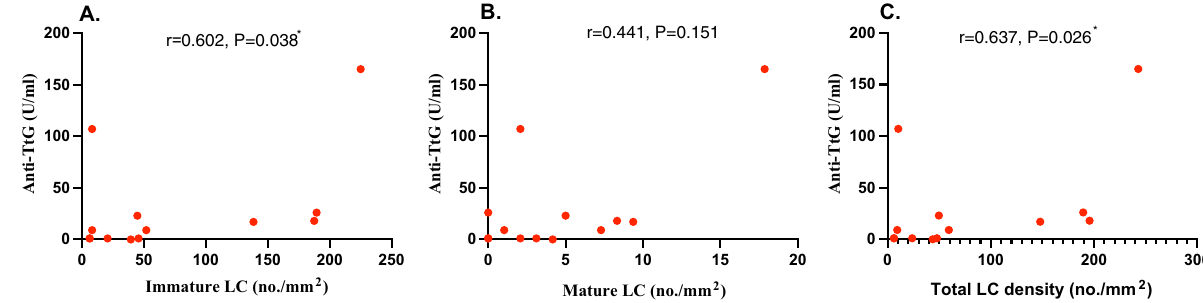
Figure 2. Correlation between Anti-TtG levels and immature ( a ), mature ( b ) and ( c ) total LC density in children with stable